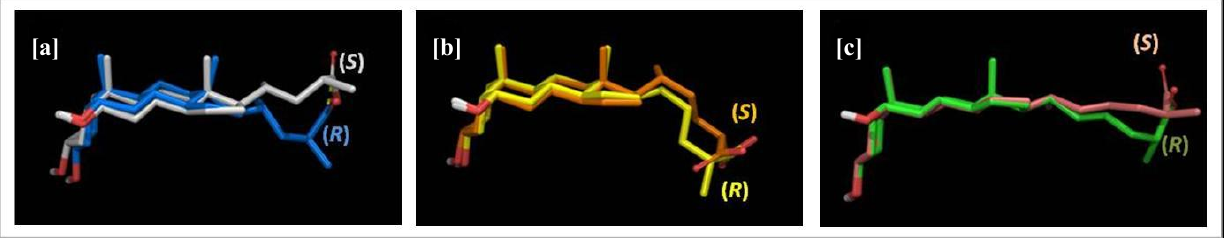
Figure 2. Overlapping of the calculated global minimum conformations of the diverse ( S ) and C ( R ) epimers 4 and 5 . ( b ) C couple of epimers. ( a ) C 24 24 and 7 . ( c ) C ( S ) and C ( R ) epimers 8 and 9 26 26